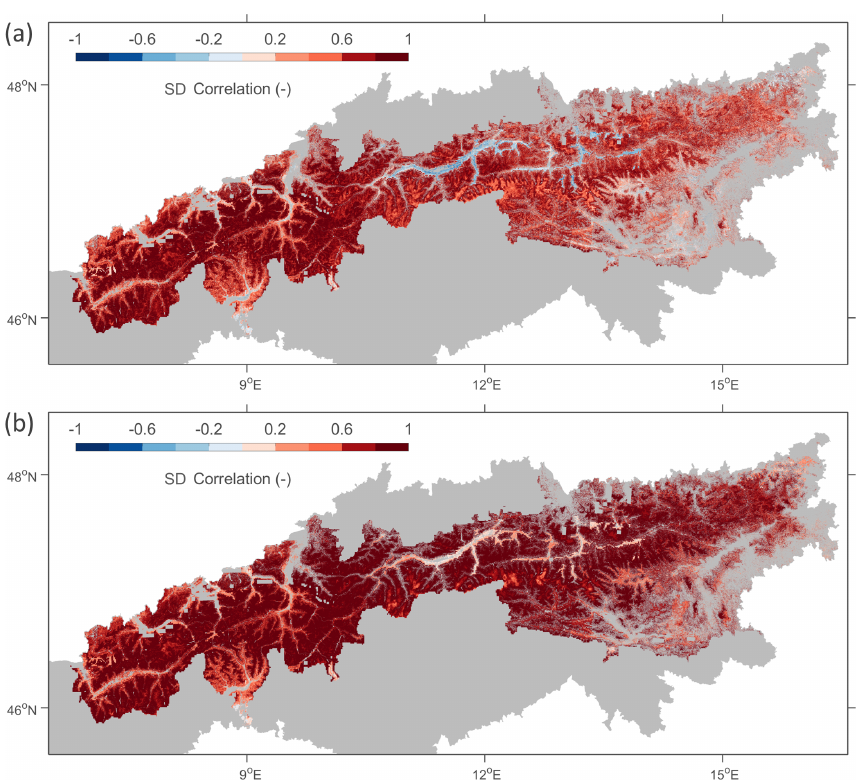
Figure 7. The time series correlations between snow depth simulations (m) and 100m S1 snow depth retrievals (m) for August through April 2017–2018 and 2018–2019, with (a) exclusion of zero snow depths (based on the model simulations) and (b) inclusion of zero snow depths. Wet snow conditions (detected by S1) are excluded in both cases.